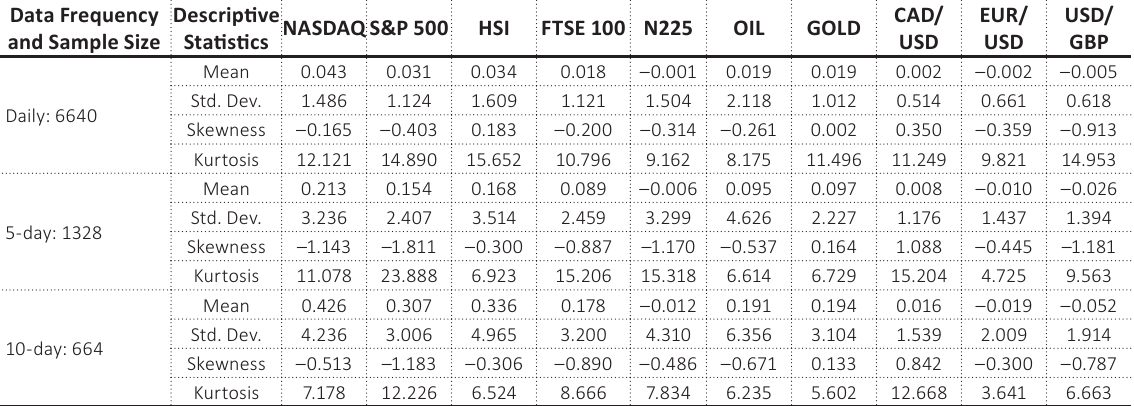
Table A1. Descriptive statistics of daily, 5-day, and 10-day returns